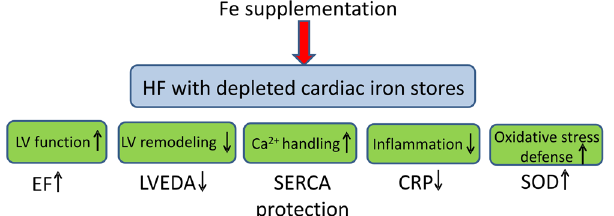
Figure 7. The beneficial effects of intravenous iron (Fe) supplementation in heart failure with normal iron status but depleted cardiac iron stories. Ejection fraction (EF), left ventricular end-diastolic area (LVEDA), sarcoplasmic reticulum Ca 2 + ATP-ase (SERCA), C reactive protein (CRP), superoxide dismutase